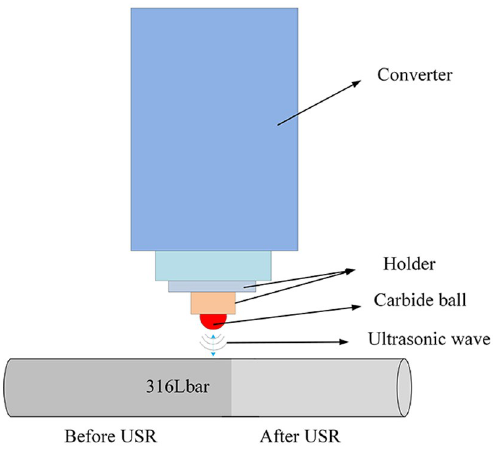
Figure 1. Schematic illustration of the ultrasonic surface rolling (USR) setup.